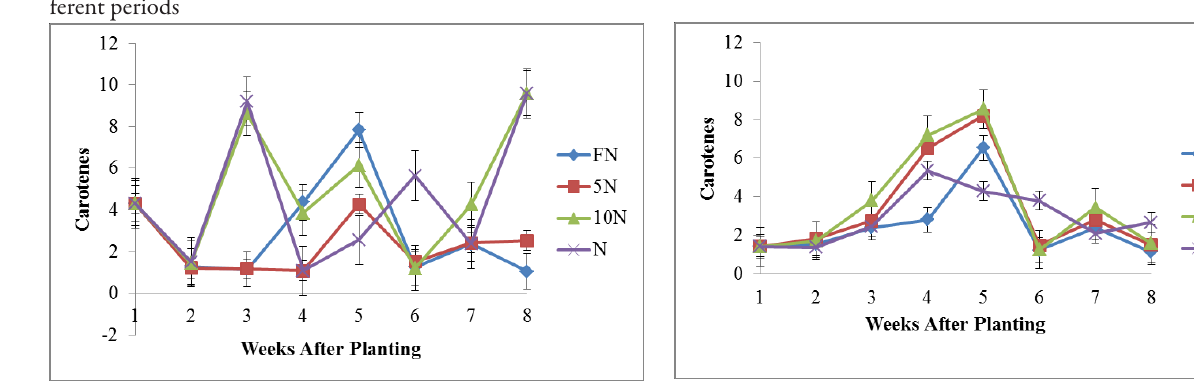
Fig. 3b. The effect of nitrogen nutritional stress on the total chlorophyll of Zea mays measured at different periods